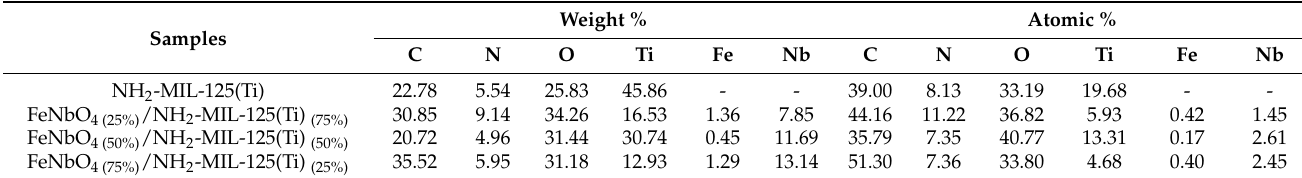
Table 2. Weight and atomic percentage of NH 2 -MIL-125(Ti), FeNbO 4 and their composites.